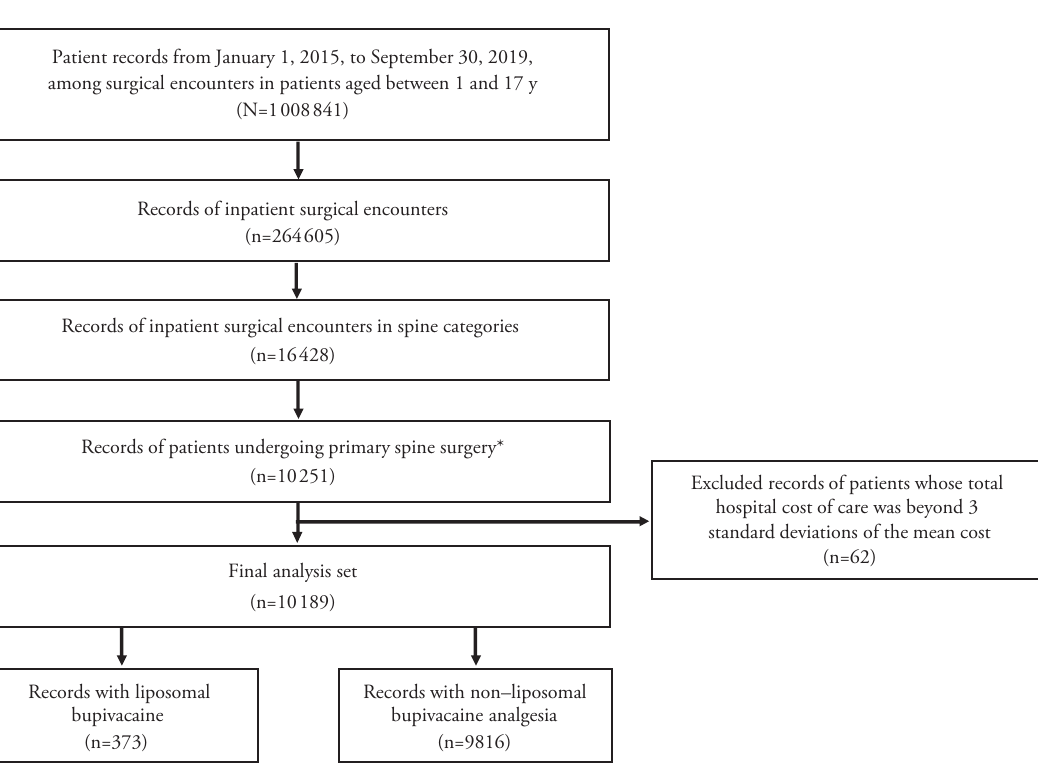
Figure 1. Surgical Records Retrieval Workflow for Pediatric Patients Undergoing Spine Surgery Patient records from January 1, 2015, to September 30,